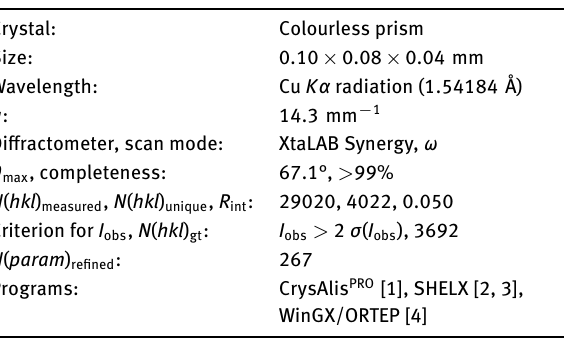
Table 1: Data collection and handling.